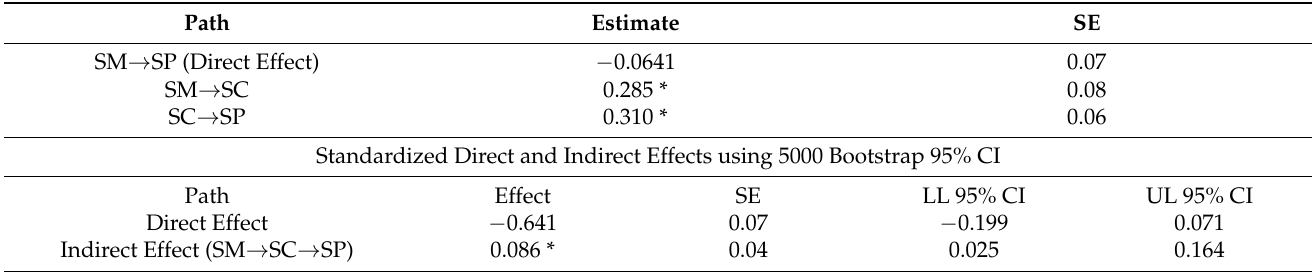
Table 3. Five thousand bootstrap results for direct and indirect effects. PROCESS Model 4 (safety consciousness as mediator).